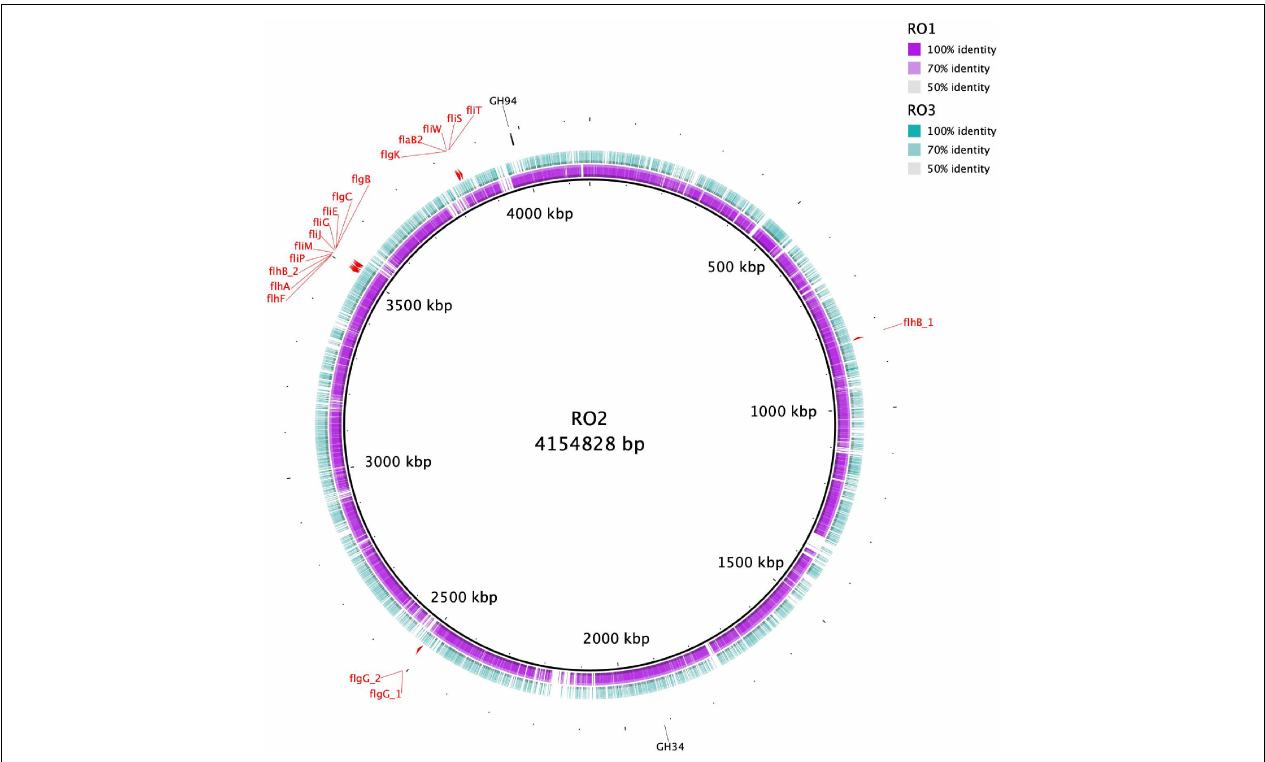
FIGURE 1 | Circular representation of RO isolates genomes. The inner black circle represents the reference RO2 genome with genetic coordinates. The colored rings show RO1 and RO3 genomes, which were used as a query. RO1 genome is more homologous to RO2 compared to RO3. The genes involved in the biosynthesis of flagella in RO2 are shown. The CAZYmes that were detected only for RO2 are also indicated.